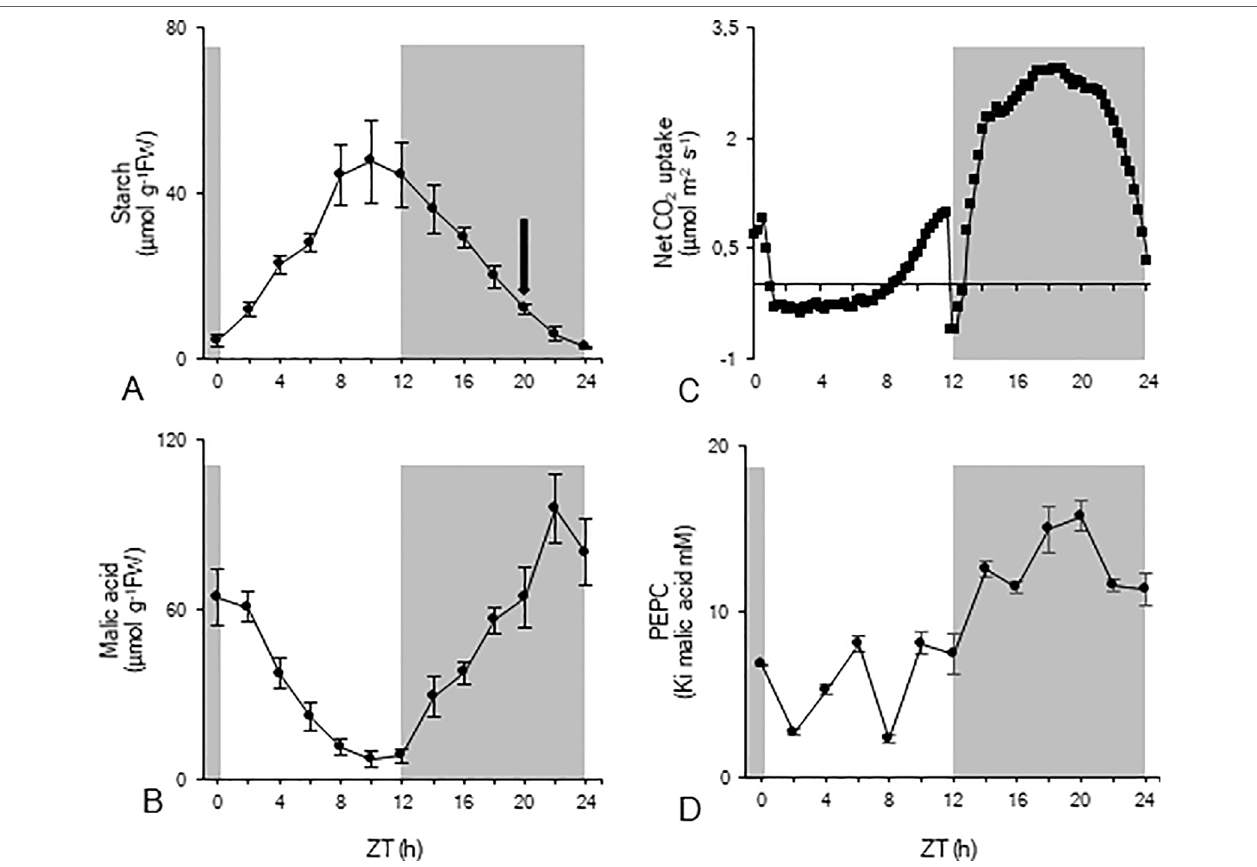
FigUrE 1 | Diel patterns of starch (µmol g -1 FW, A ), malic acid (µmol g -1 FW, B ), leaf gas exchange (µmol m -2 s -1 , C ), and Ki of PEPC for malic acid (mM, D ) for young fully developed leaves of Phalaenopsis ‘Edessa’. The black arrow in panel (A) indicates the division of the nocturnal period based on the calculated starch degradation rates. The dark period is indicated in grey. Data are means ± SD (n = 5 for A , B and D ; n = 3 for C